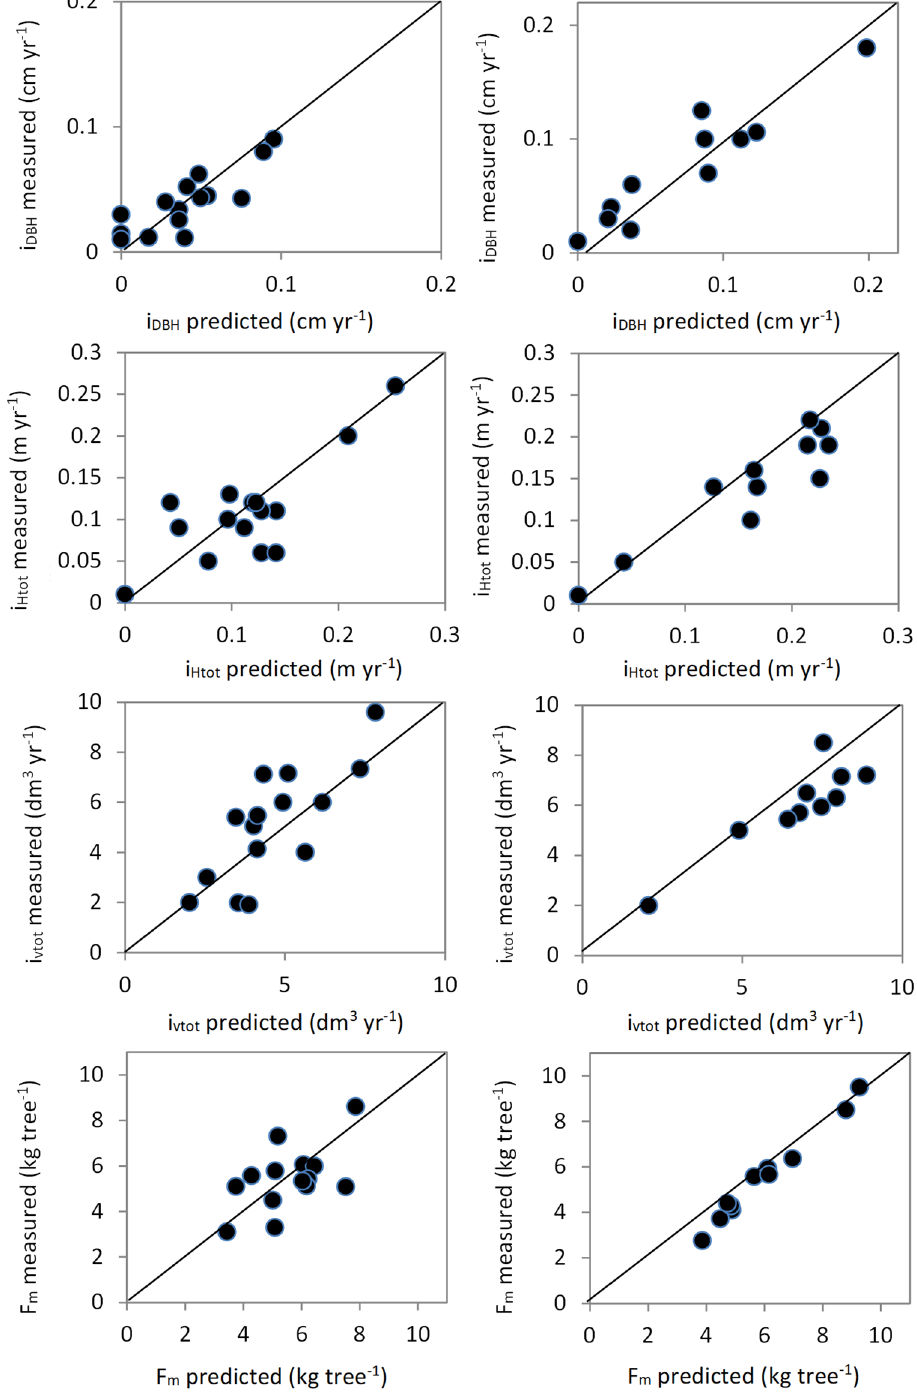
Figure 2. Relationship between empirical and predicted variables at the tree scale for increments in diameter at 1.30 m (i DBH ), height (i Htot ), volume (i Vtot ), and total tree foliage biomass (F m ) for jack pine and black spruce six years following stand density decrease. All black filled circles include trees coming from a control plot with non-management and from plots with basal areas removed, ranging from 16 to 72% for jack pine and 51 to 76% for black